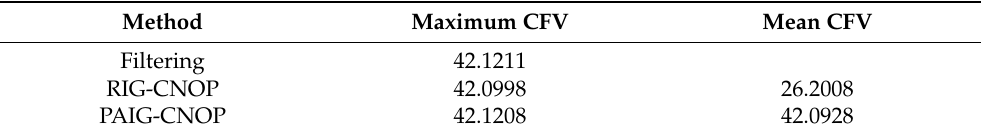
Figure 6. The distribution of the CFVs corresponding to the initial guesses generated by the different methods at point B , T = 500. Table 5. Statistical analysis of the CFVs corresponding to the initial guesses generated by the different methods at point B , T =